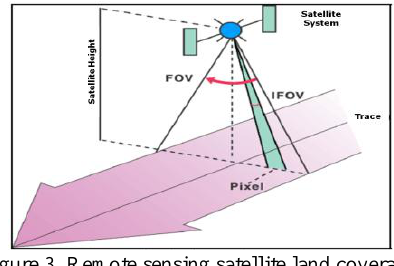
Figure 3. Remote sensing satellite land coverage